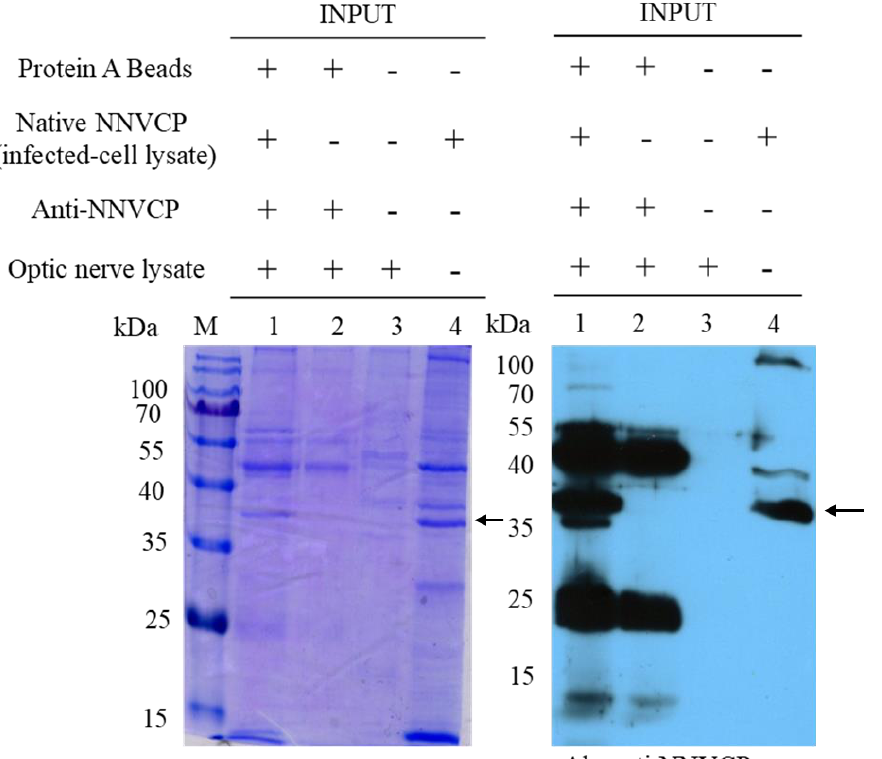
Figure 1. Nervous necrosis virus capsid protein (NNVCP) interactions with grouper optic nerve proteins. SDS-PAGE and Western blot analysis of the grouper proteins that interact with NNVCP by immunoprecipitation (IP) assay. The sample was loaded in every well (listed above the gel) and then detected with the NNVCP antibody. Each well was loaded with 20 µg of protein. Lane 1: lysates from grouper optic nerve and native NNVCP were subjected to immunoprecipitation with Protein A beads. Lane 2: lysates from grouper optic nerve were subjected to immunoprecipitation with Protein A beads (negative control). Lane 3: lysates from non-infect grouper optic nerve. Lane 4: Native NNVCP from infected-cell lysate. The arrow indicates native NNVCP. Table 2. The original protein assay data in the grouper optic nerve with native NNVCP by immunoprecipitation. The gray font indicates the proteins that were also detected in the control group.